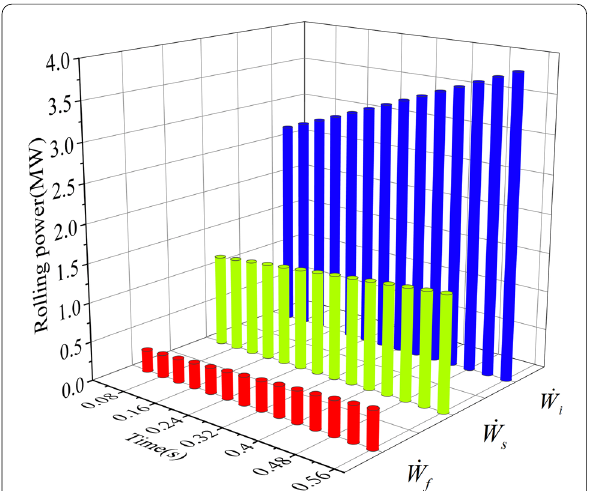
Figure 12 Variation of powers in downward rolling